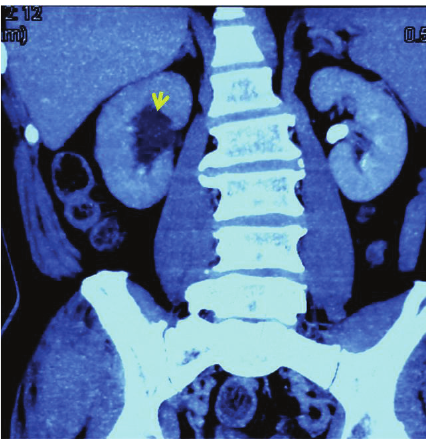
Figure 1: Computed tomography urography demonstrated right hydronephrosis secondary to thickening of the distal